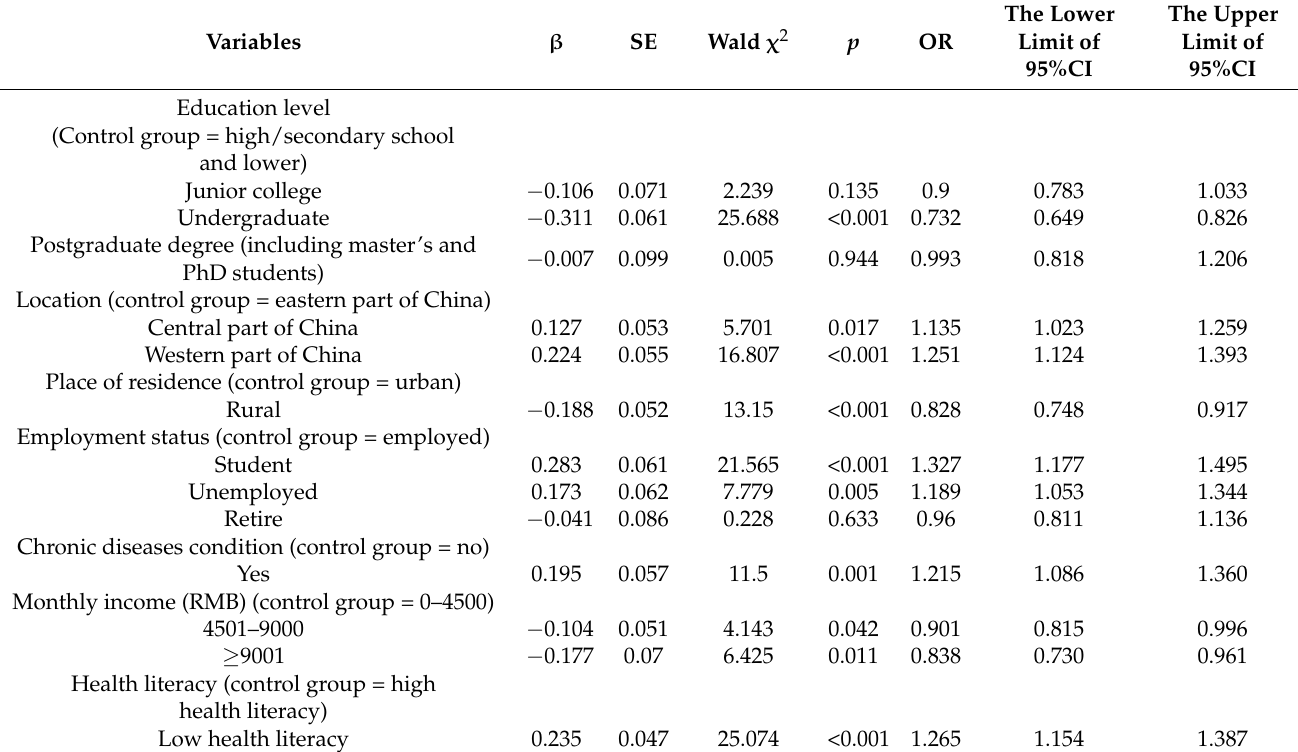
Table 5. Multi-factor binary stepwise logistic regression results with whether the respondents consider drug price as an important consideration as the dependent